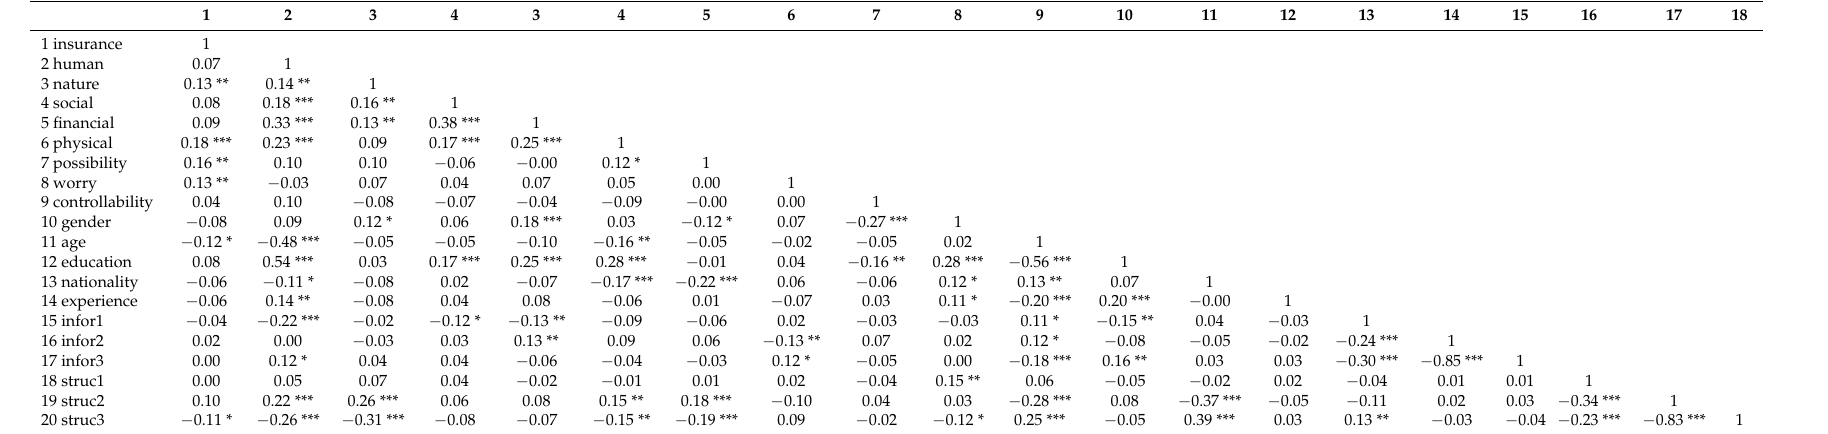
Table 5. Pearson product moment correlation coefficient or Spearman rank order correlation matrix of model